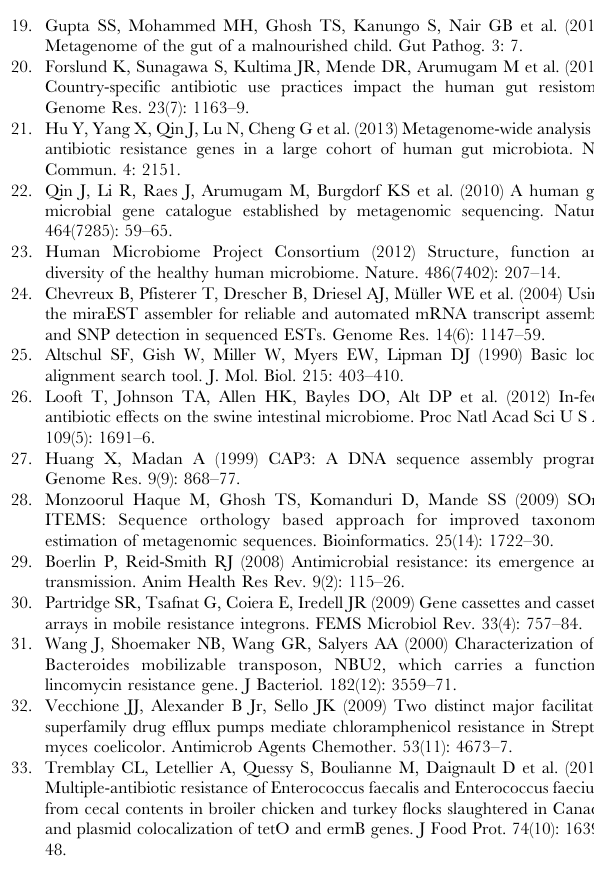
Table S1 Details of the gut metagenomes considered for the present analysis. Table S2 Details of the antibiotic against which the resistance genes (and their taxonomic origin) in the gut metagenomic data sets obtained from the (A) American (B) Spanish (C) Danish (D) French (E) Italians (F) Indian (G) Japanese and (H) Chinese. The numbers (in brackets) shown for each taxonomic group, indicate the number of contigs (in a given sample) that had the given antibiotic resistance profile and were assigned to the given taxonomic group (based on the alignment parameters). Table S3 Detection of various antibiotic resistance genes in the analyzed gut metagenomes. Resistance to multiple antibiotics are indicated by *. Table S4 Nomenclature used for the identified multi- antibiotic resistance profiles along with the specific geographies where observed. Table S5 The normalized abundance of (A) Resistance diversity and, (B) Resistance genes, obtained for the 275